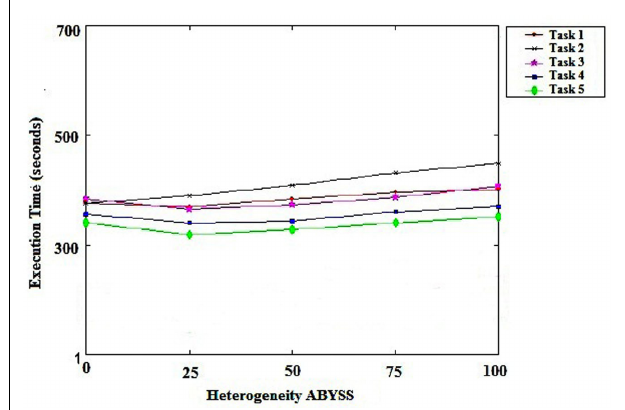
FIGURE 2 | Machine heterogeneity.